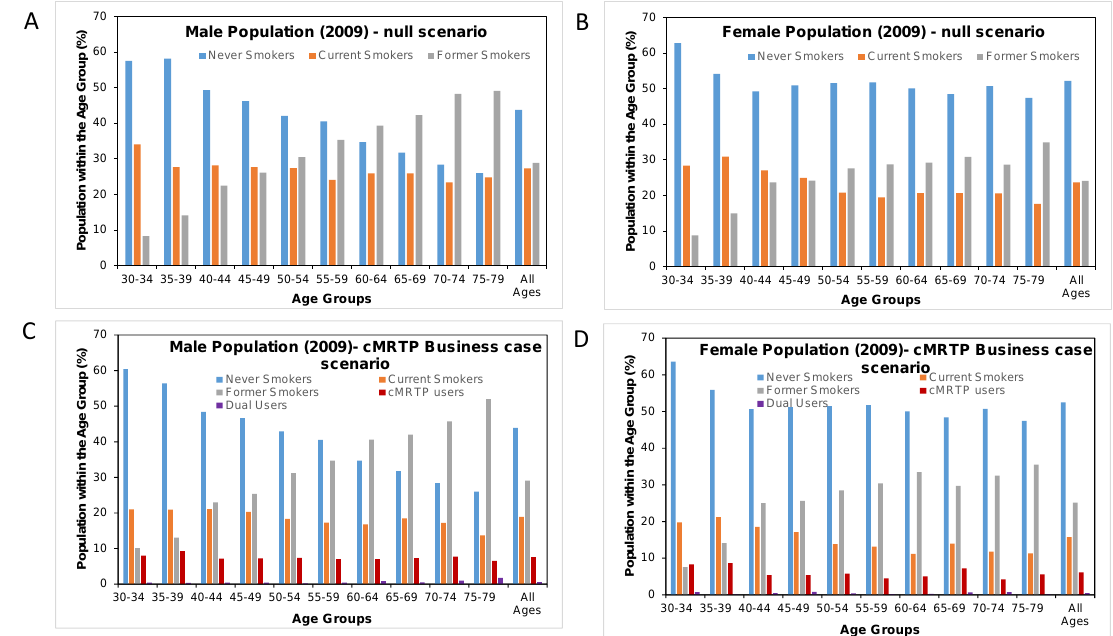
Figure 3. Distribution of smoking patterns by age and sex in 2009 in the null scenario and in the cMRTP uptake case scenario. ( A ) is the distribution of smoking patterns by age in the male population under the null scenario while ( C ) is the same male population under the Business case scenario. ( B ) is the distribution of smoking patterns by age in the female population under the null scenario while ( D ) is the same female population under the Business case scenario.